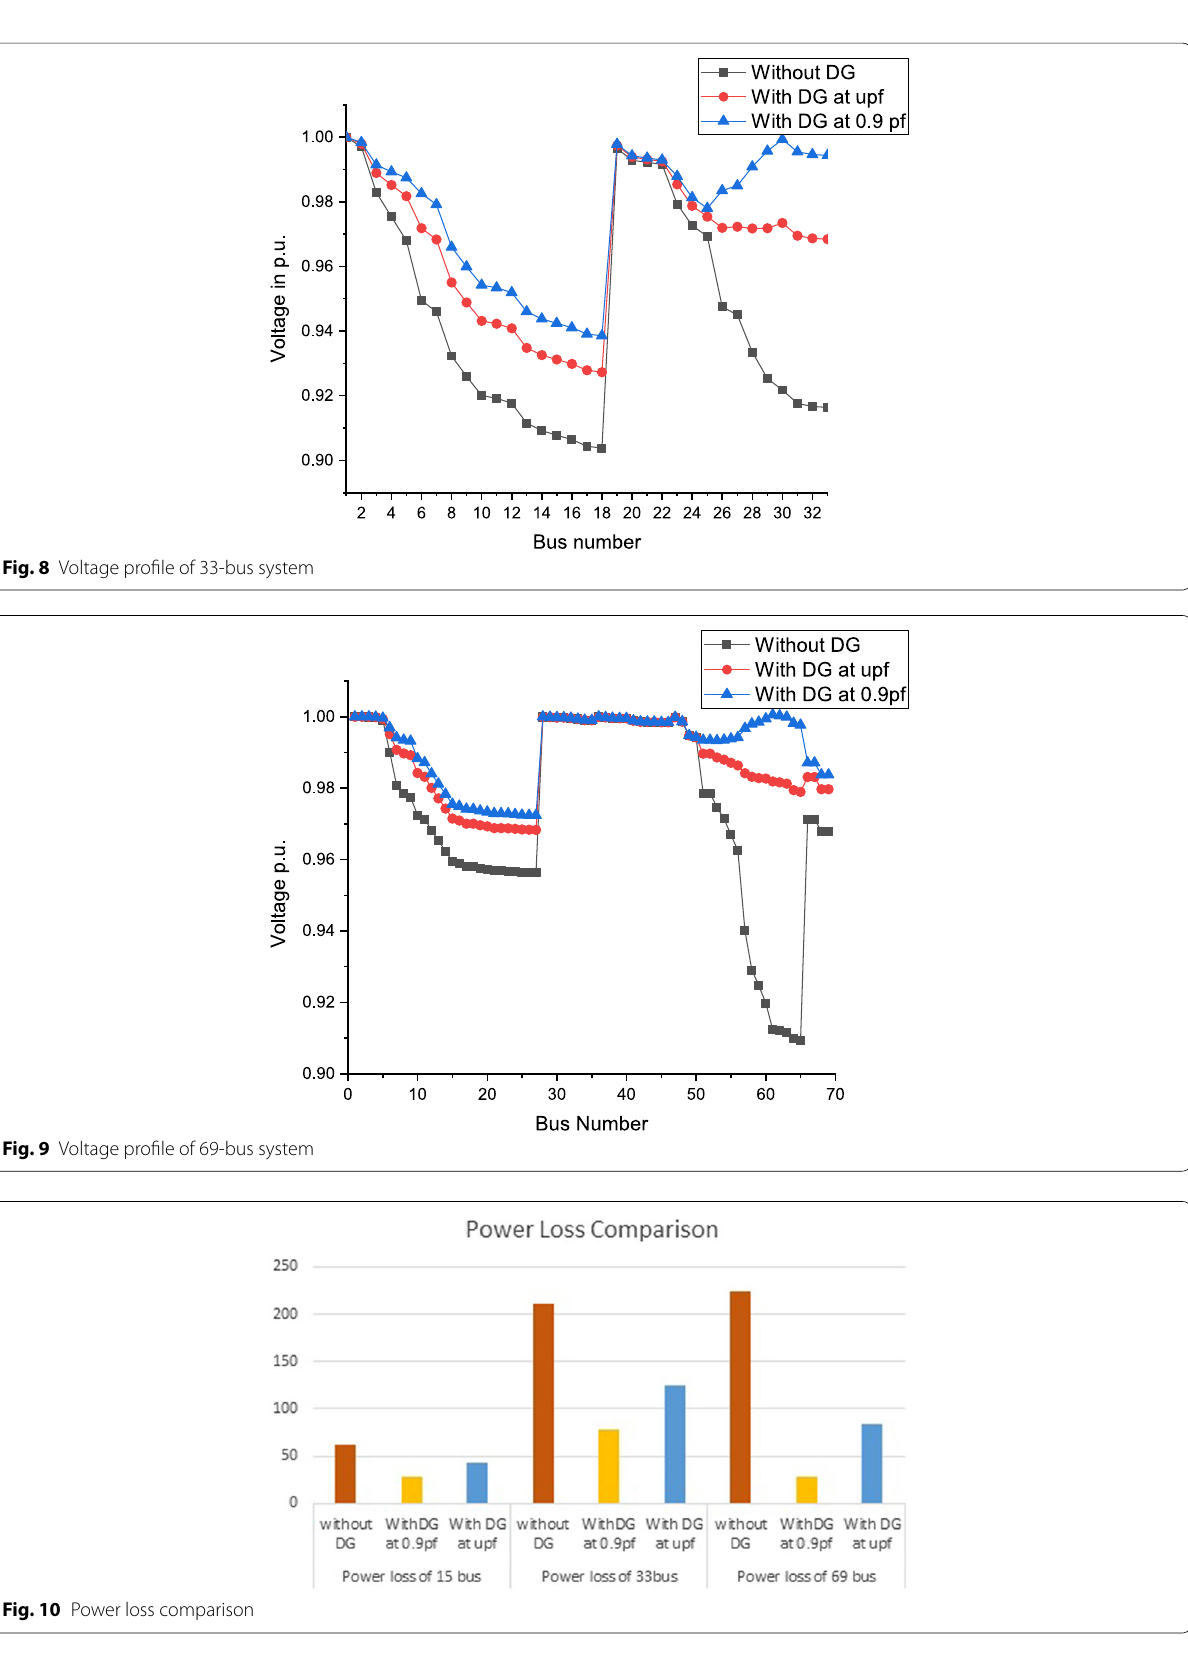
Fig. 10 Power loss